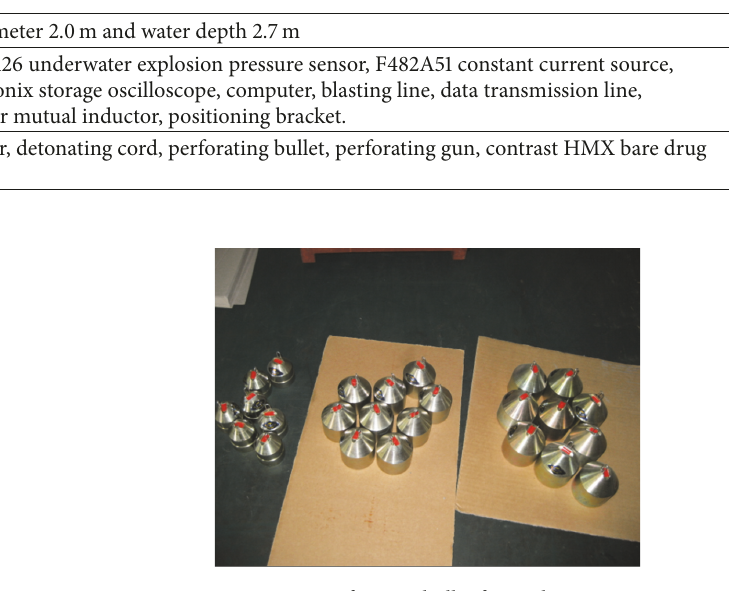
Figure 8: Explosion test pool and positioning bracket. Figure 9: Perforating bullet for explosive test.